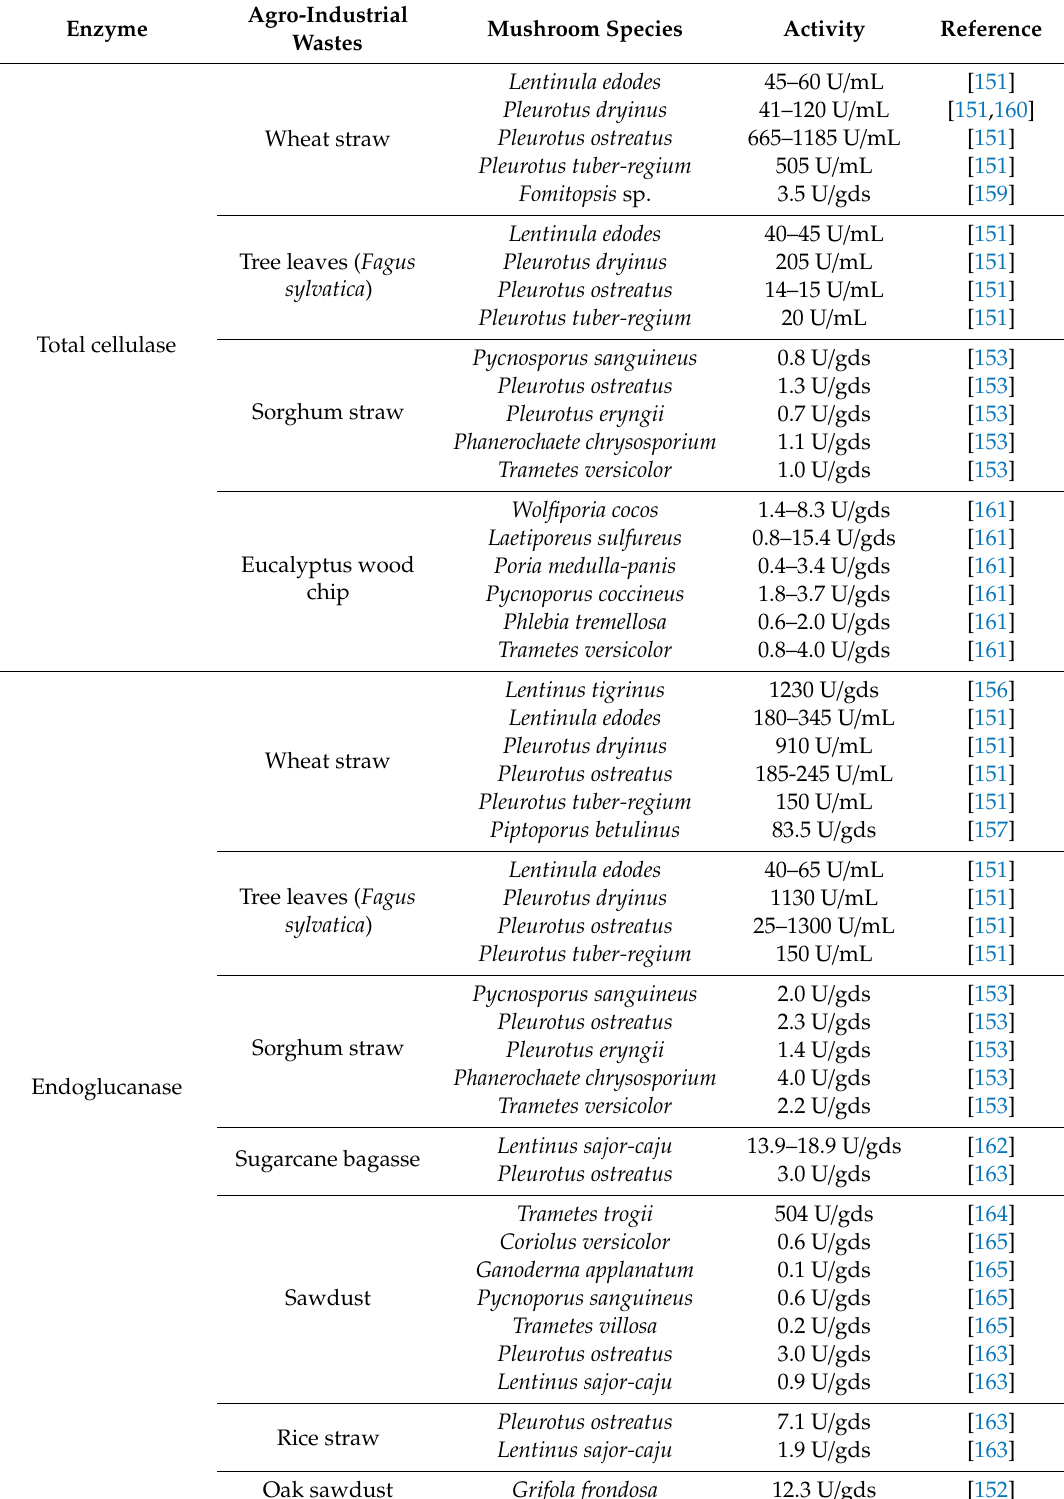
Table 5. Production of enzymes in solid state fermentation of cellulose degradation by some mushrooms using agro-industrial